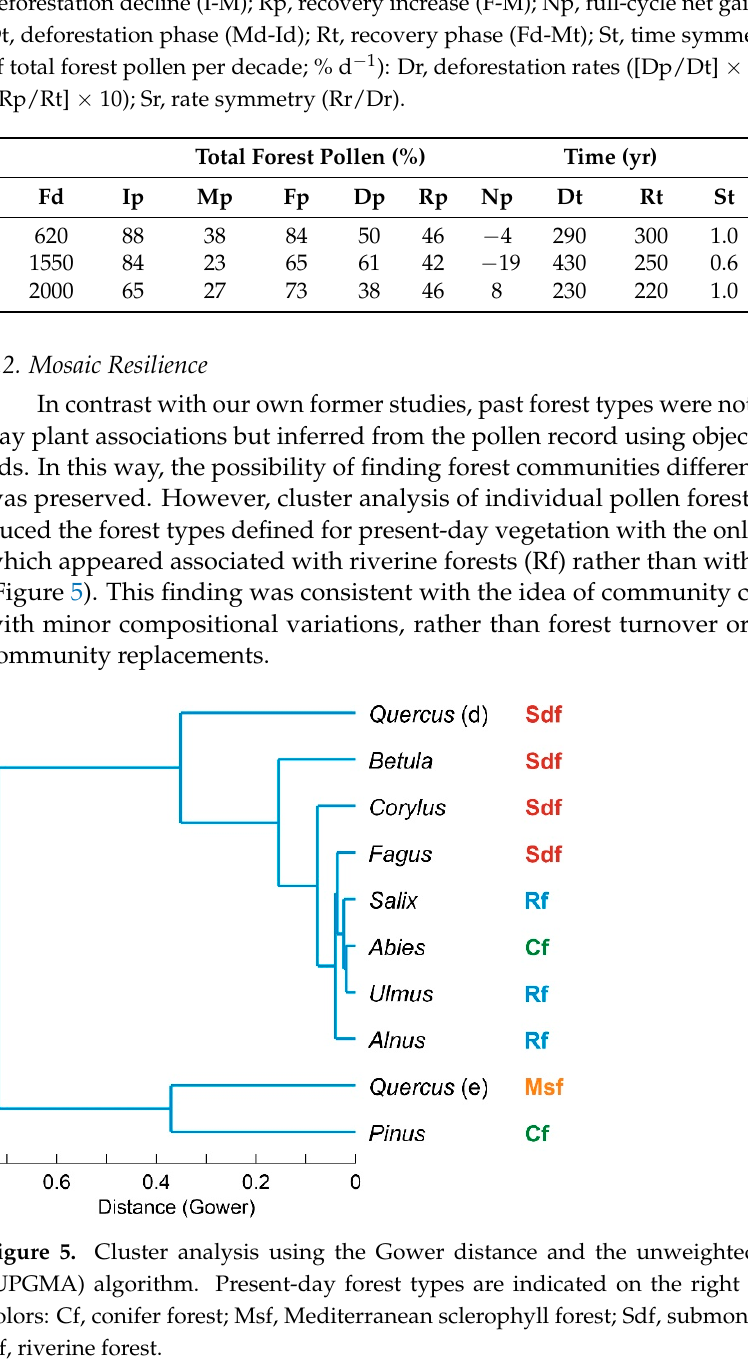
Table 2. Correlations of forest types (Figure 5) with total forest pollen for the total data set (overall) and for each specific deforestation and recovery phase (Figure 4). Forest types: Cf, conifer forest; Msf, Mediterranean sclerophyll forest; Sdf, submontane deciduous forest; Rf, riverine forest. Corre- lation significance: ** p < 0.01.